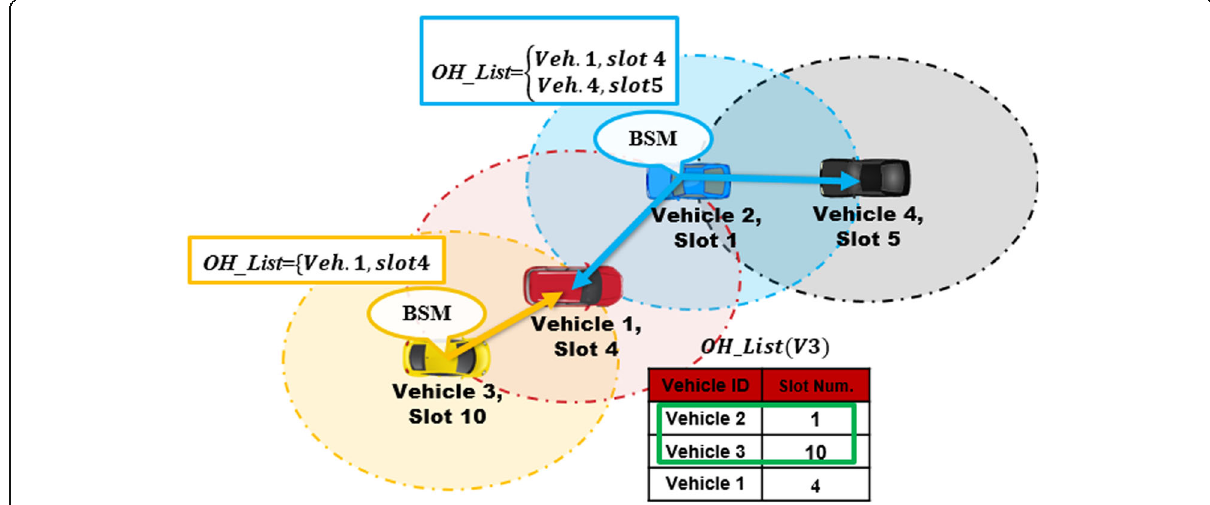
Fig. 5 An example of how BSM messages can act as implicit acknowledgements